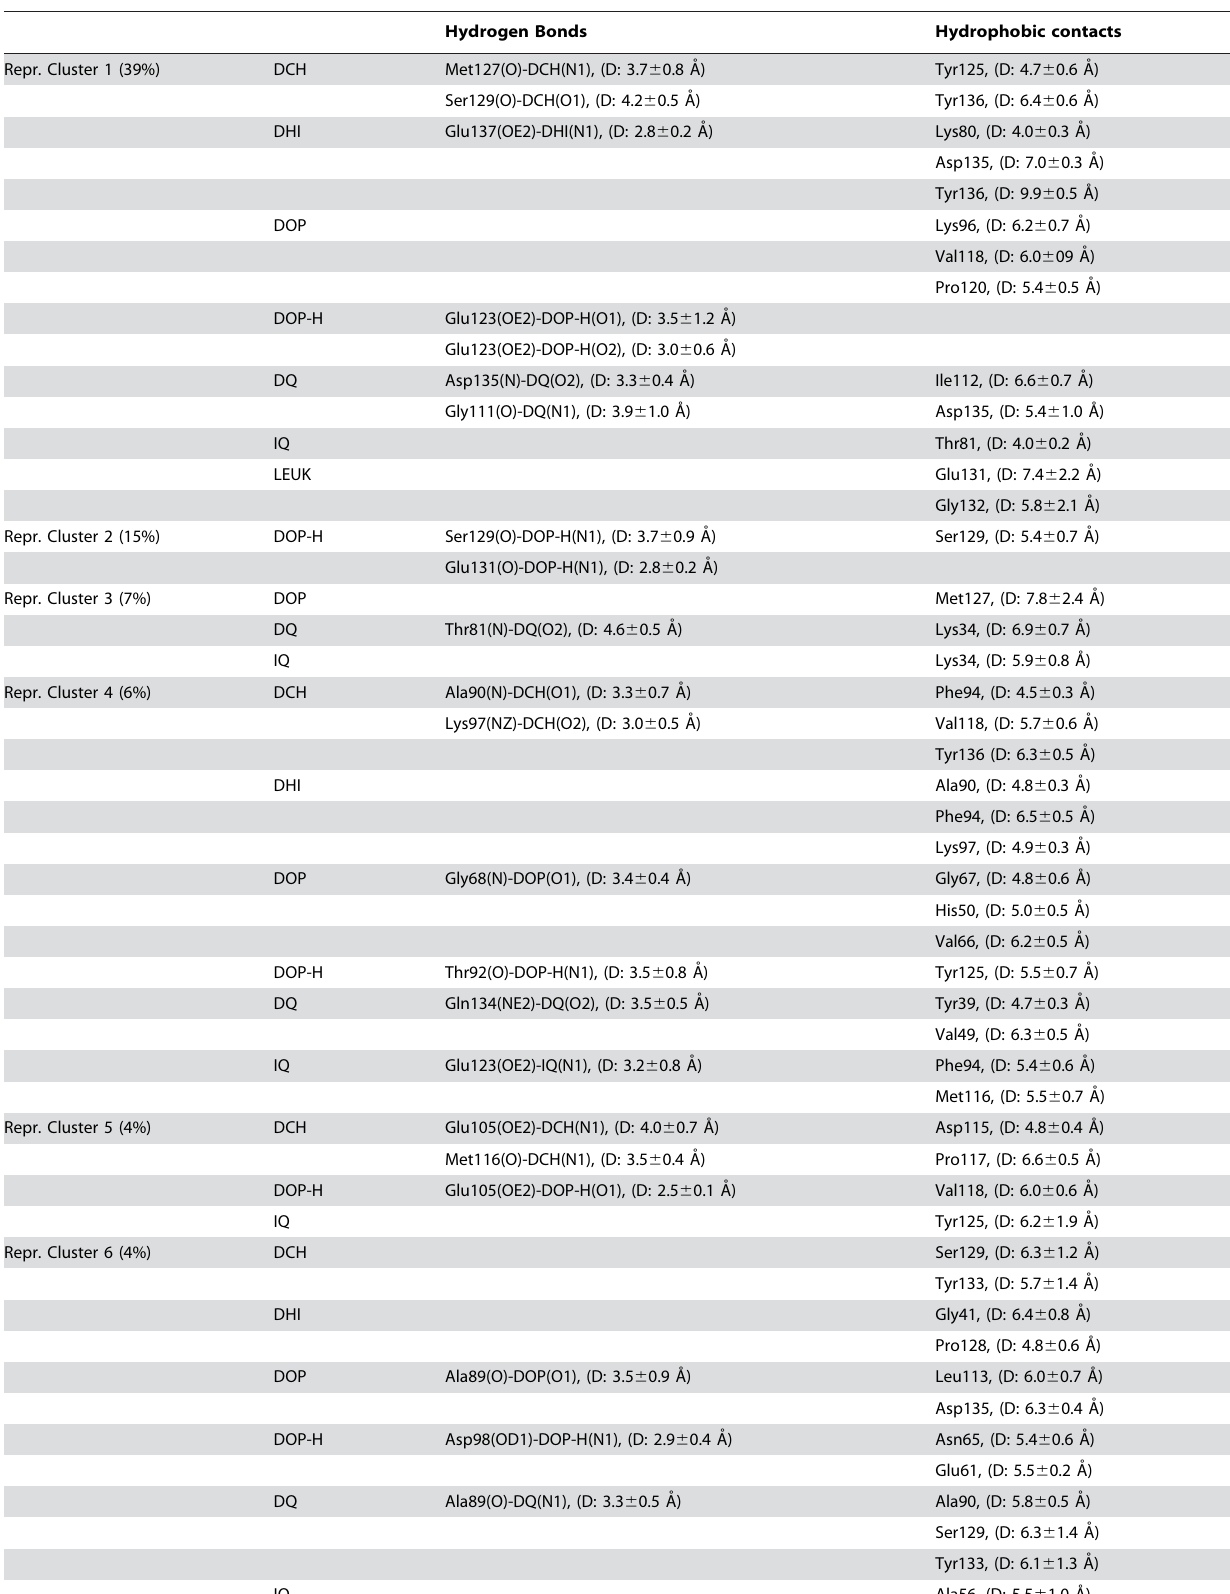
Table 1. H-bond and hydrophobic contacts in Dopamine N AS ‘stable’